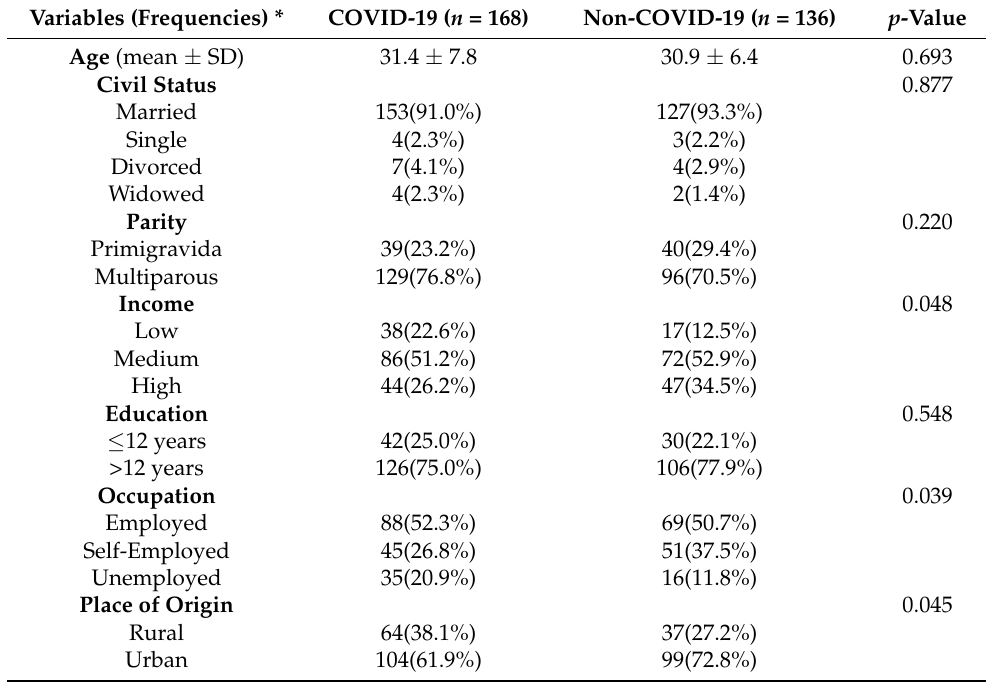
Table 1. General characteristics of the study groups.